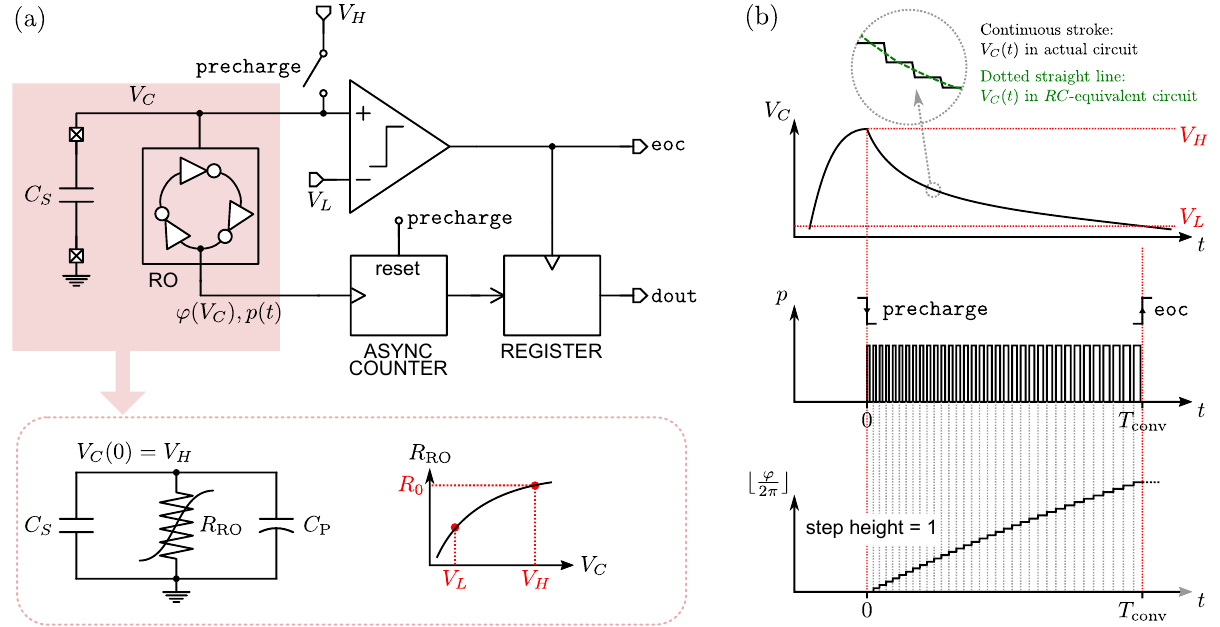
Figure 2. Simplified CDC operation based on a voltage level comparator: ( a ) block-level schematic